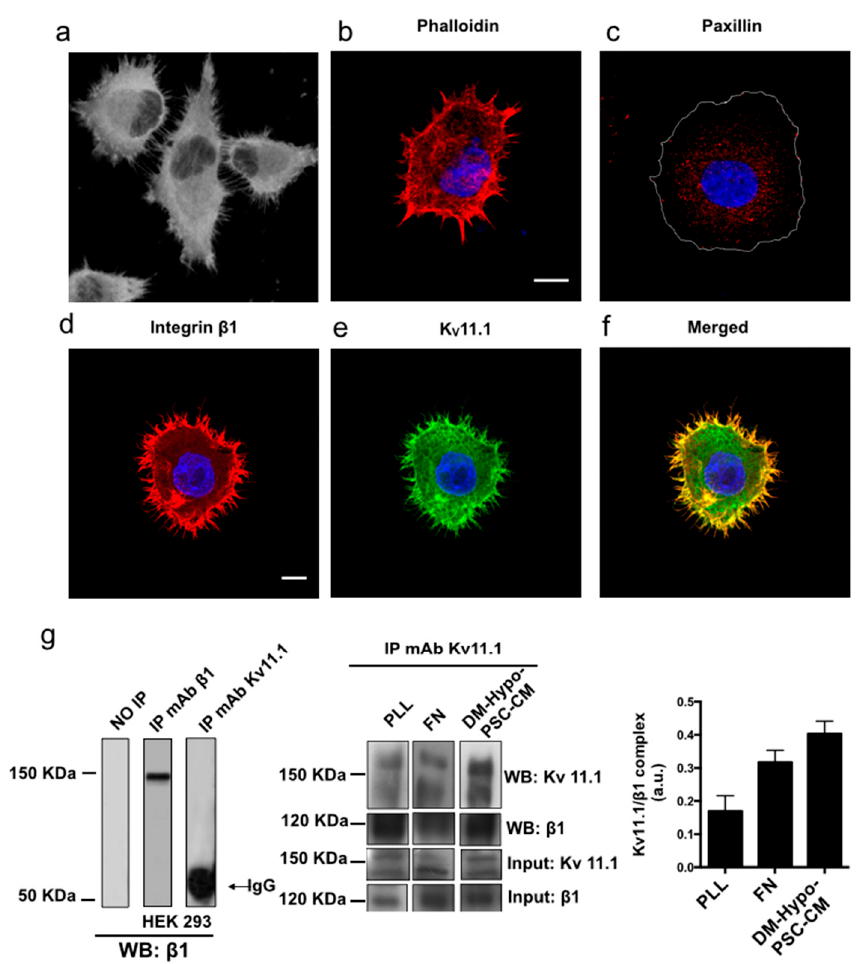
Figure 4. Phalloidin staining, K V 11.1, β 1 integrin and paxillin expression in PANC-1 cells cultured onto desmoplastic matrix (DM) plus hypoxia (Hypo-PSC-CM). ( a ) Representative confocal image of PANC-1 cells. Scale bar: 10 µ m. ( b ) Representative single cell image of fixed PANC-1 stained with anti-paxillin primary antibody and revealed with AF546-conjugated anti-mouse secondary antibody. Nuclei are Hoechst stained in blue. ( c ) Representative single cell image of fixed PANC-1. Actin staining by rhodamine-conjugated phalloidin (red). ( d – f ) Cells were stained for β 1 integrin with ts2/16 primary antibody and revealed with AF546-conjugated anti-mouse secondary antibody; for K V 11.1, anti-hERG1 mAb-AF488 conjugated antibody. Co-localization of K V 11.1 and β 1 integrin is reported (Merged, third panel from the left). ( g ) Co-immunoprecipitation of K V 11.1 and β 1 integrin in PANC-1 cells after seeding on Polylysine (PLL), FN, or DM plus Hypo-PSC-CM, for 90 min. Total lysate was immunoprecipitated using anti-hERG1 antibody (IP mAb K V 11.1). Western blotting was performed on immunoprecipitates and total lysates (input) from the same sample, with either anti-K V 11.1 antibody or anti- β 1 antibody. The corresponding densitometric results are given in the bar graph on the right. The control data are shown in the left panel: left lane no immunoprecipitate; middle lane immunoprecipitate on HEK 293 cells with anti β 1 antibody (molecular weight immunoprecipitated β 1 integrin approximately 120 kDa); right lane immunoprecipitate on HEK 293 cells (not expressing K V 11.1) with anti-hERG1 antibody (IP mAb K V 11.1). Wester blotting was performed using anti β 1 antibody.